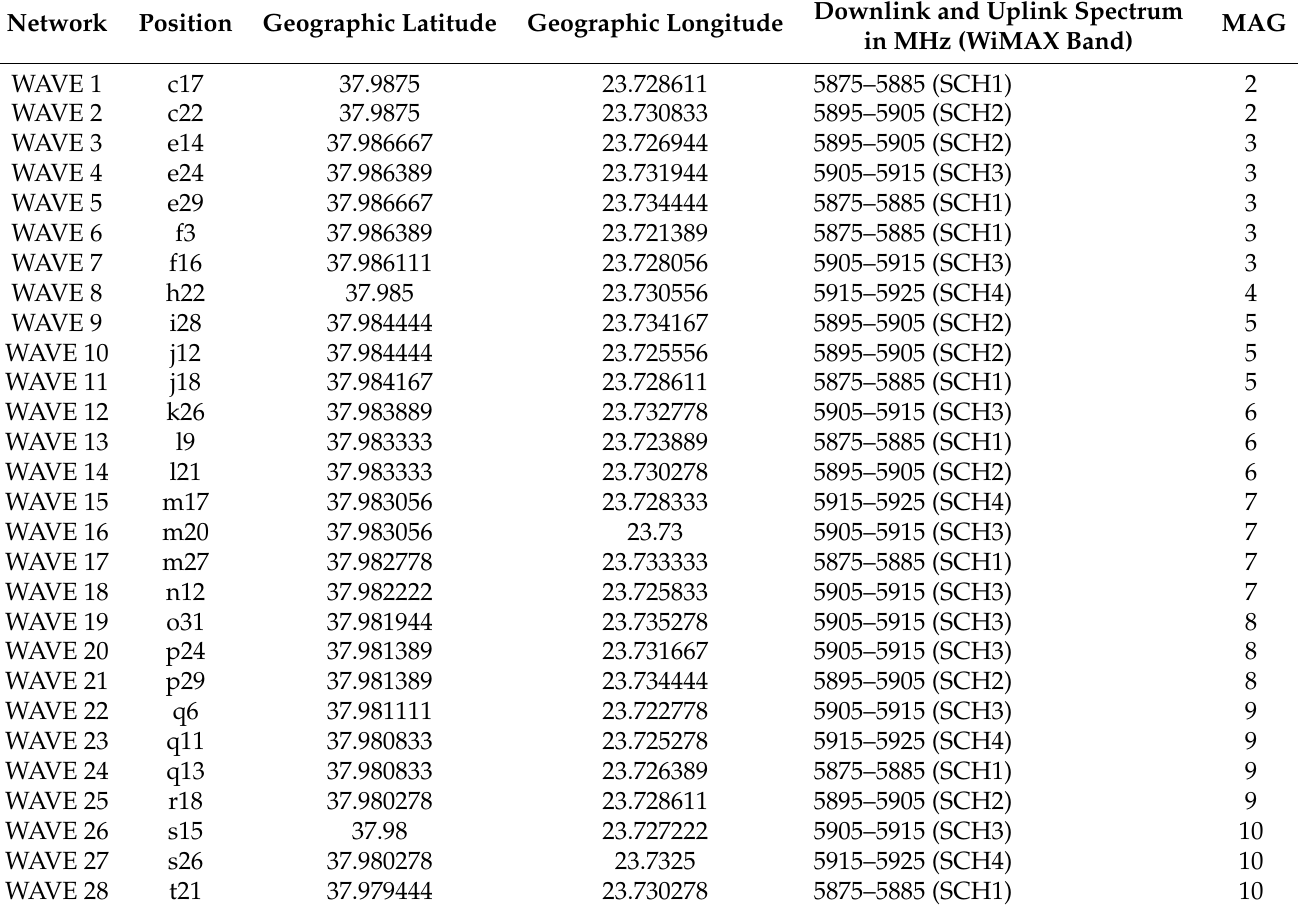
Table A1. The positions and the frequencies of the simulated WAVE networks.